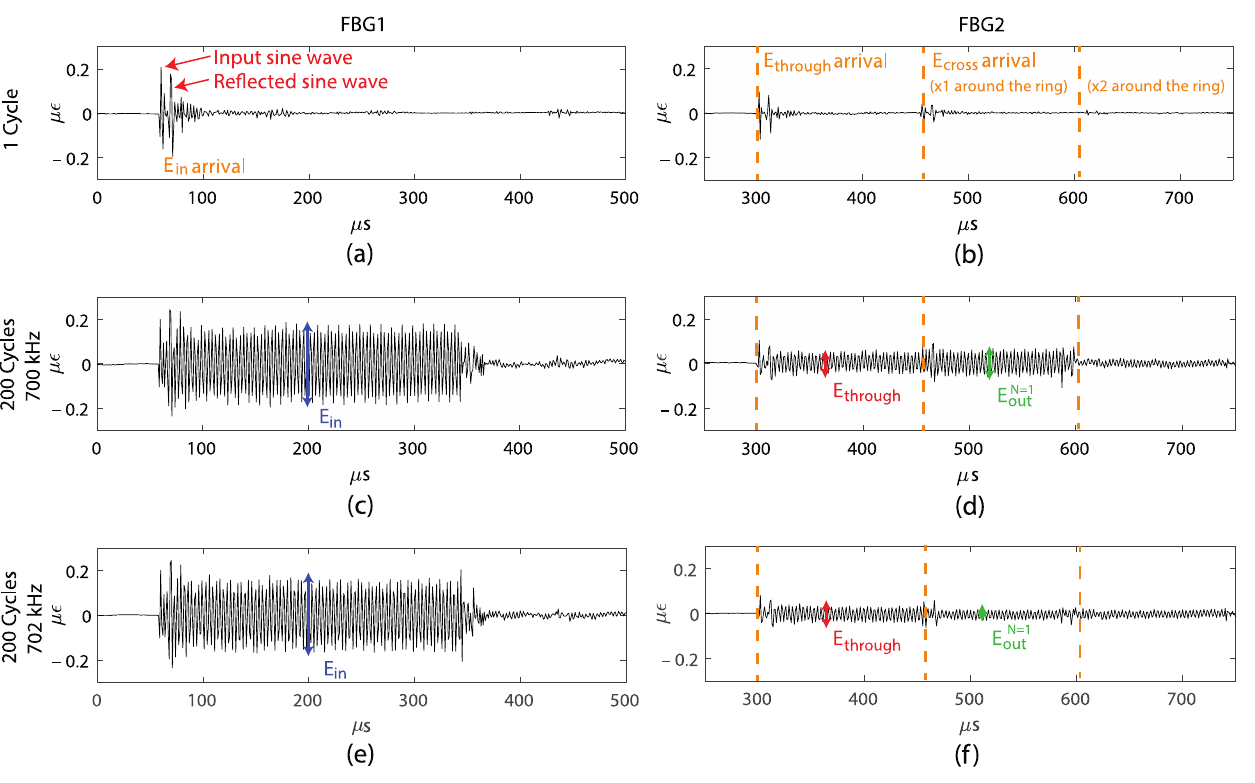
Figure 4. ( a ) FBG1 measurement for 1 cycle per burst, ( b ) FBG2 measurement for 1 cycle per burst, ( c ) FBG1 measurement for 200 cycles per burst at 700 kHz, ( d ) FBG2 measurement for 200 cycles per burst at 700 kHz, ( e ) FBG1 measurement for 200 cycles per burst at 702 kHz, and ( f ) FBG2 measurement for 200 cycles per burst at 702 kHz.